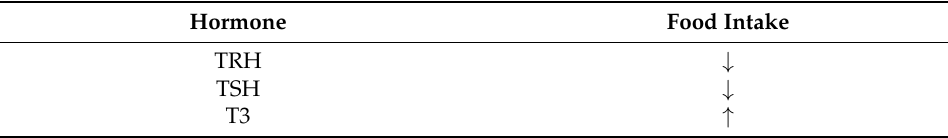
Table 1. Effect of TRH, TSH and T3 on